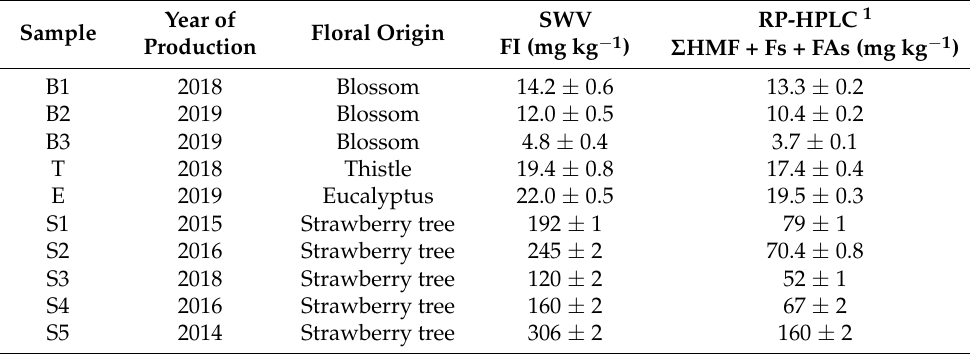
Table 7. Furanic index (FI) in ten honeys of different floral origin and age. Comparison with RP-HPLC data.